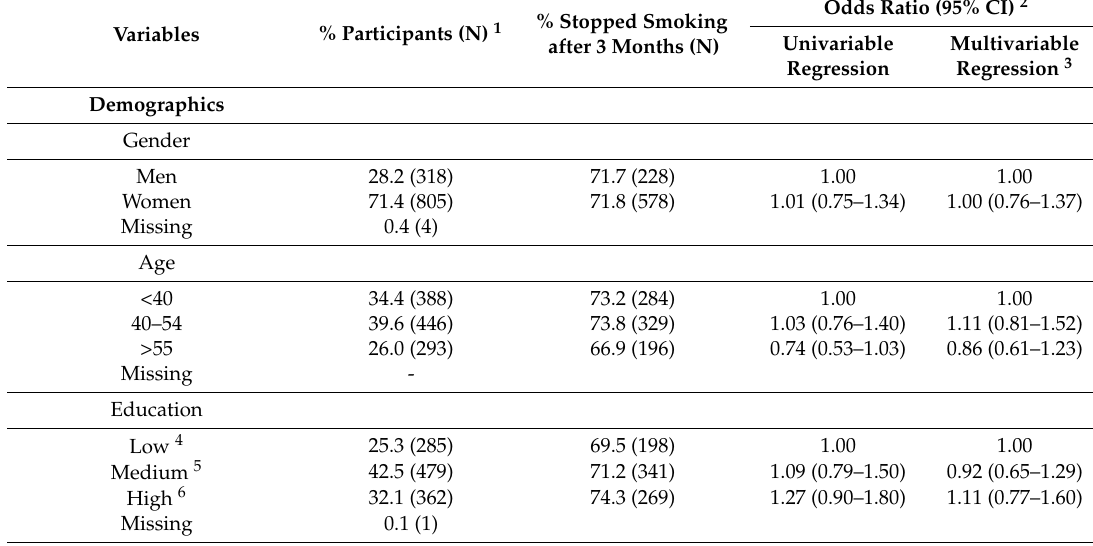
Table 1. Demographic characteristics and smoking variables and their association with not smoking after three months ( n =